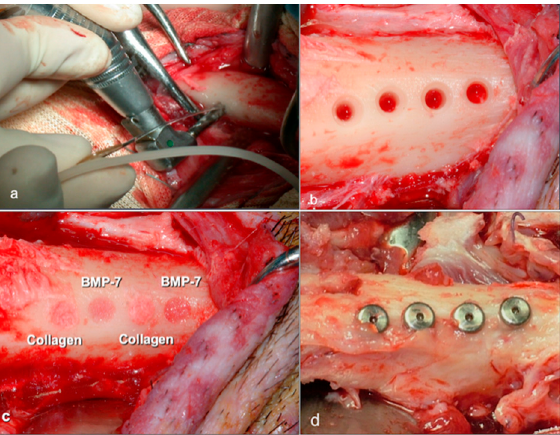
Figure 2. Example of implant site preparation: ( a , b ), treated with rhBMP-7 or collagen ( c ). Implant sites, at 56 days, before sliced dissection ( d ).